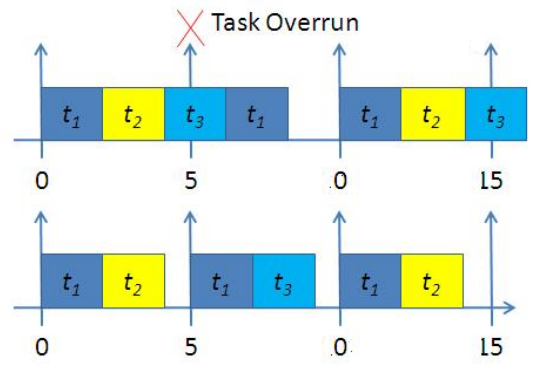
Figure 2. Effect of task release times on feasibility, showing (top): a synchronous infeasible task set with  = {(5,2),(10,2),(10,2)}; (bottom): an asynchronous (feasible) version of this task set with release time of 1 tick – 5 time units - added to t